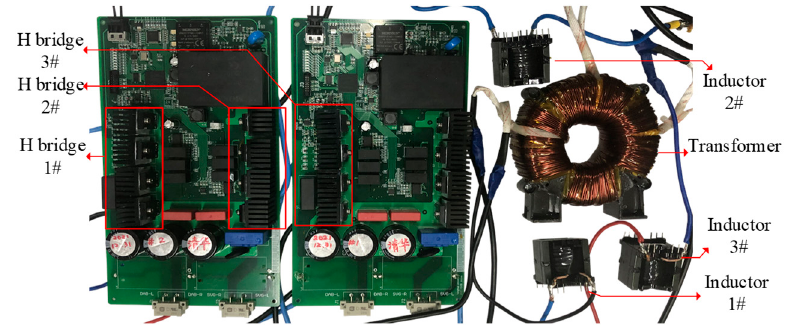
Figure 11. Experimental prototype.